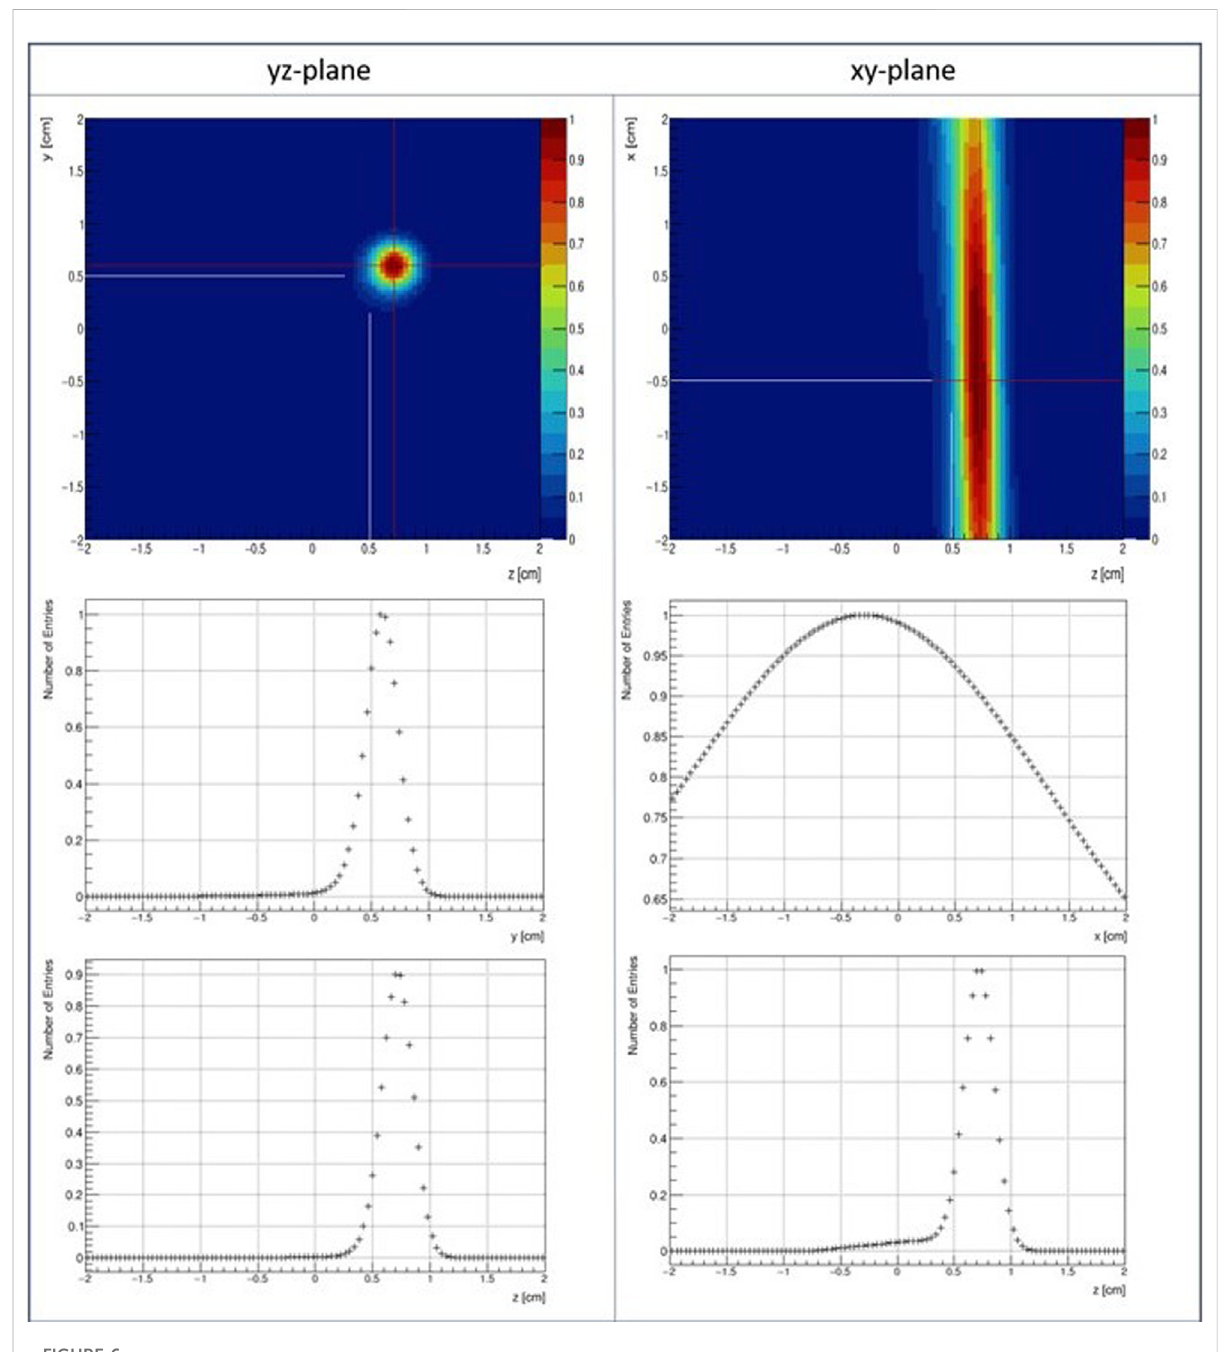
FIGURE 6 Pointspreadfunctionsofa 22 Napointsourceplacedatx= − 5 mm,y=5 mmandz=5 mmandreconstructedinPET-onlymode(toprow)anda slice though one bin (indicated by the red lines) along the two respective dimensions (central, bottom row). The intersection of the (extrapolated) white lines indicates the actual source